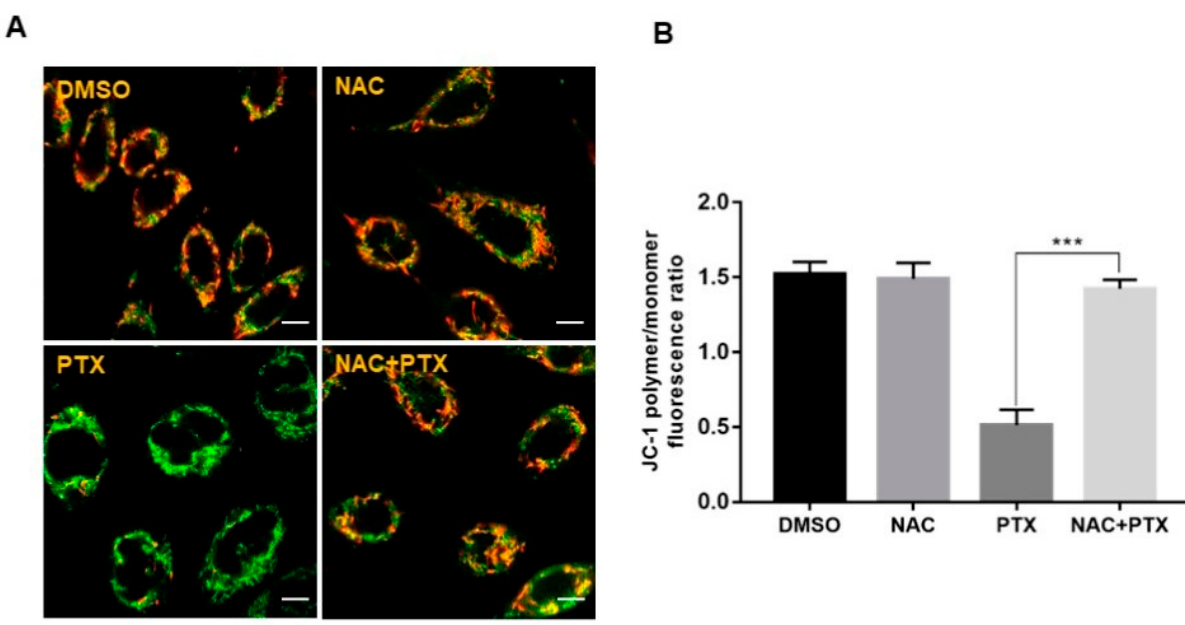
Figure 4. Paclitaxel induced apoptosis through ROS-dependent mitochondrial pathway in PC3M cells. ( A , B ) Alterations in the mitochondrial membrane after the treatment with paclitaxel were ob- served by JC-1 staining, following the treatment with paclitaxel with or without NAC. Scale bars = 10 μ m. Results are expressed as mean ± SD, n = 3. ***: p < 0.001.